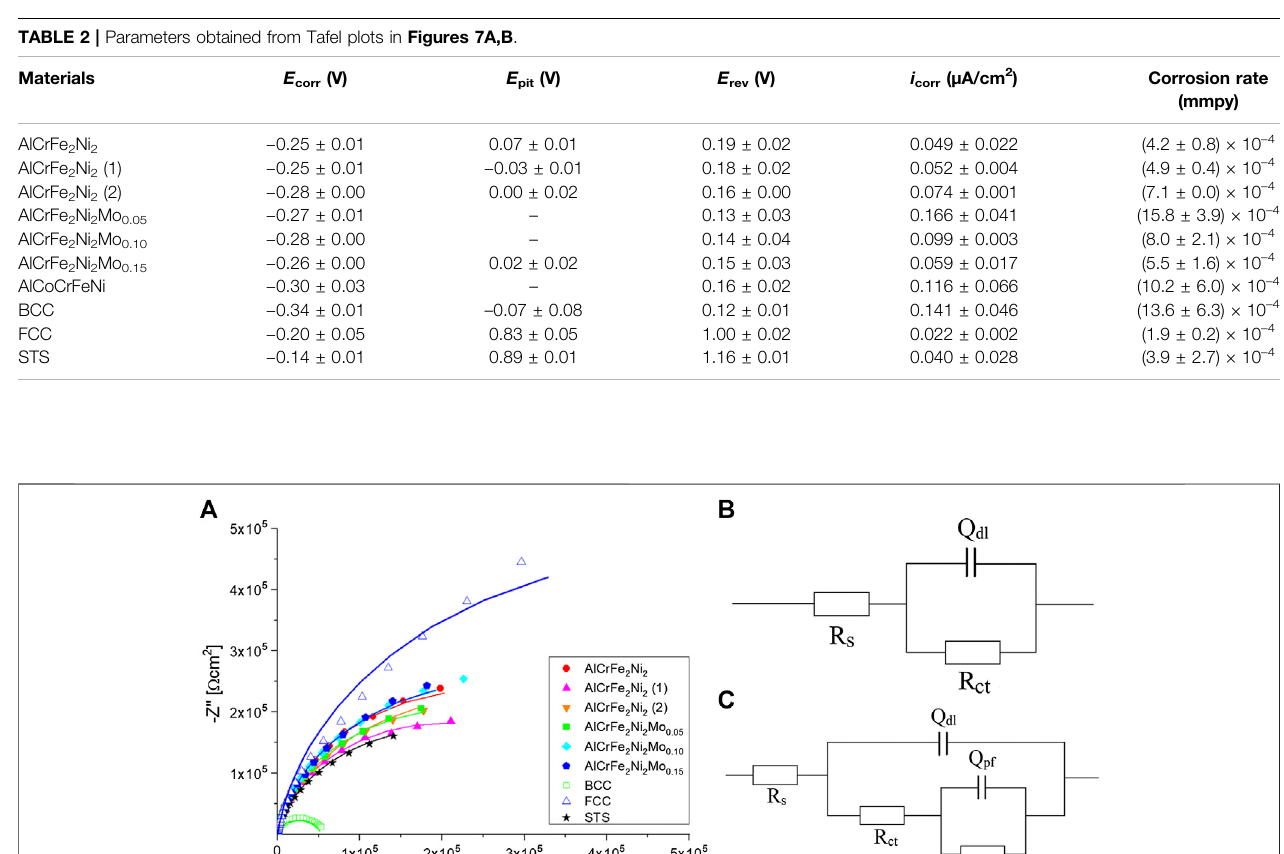
Frontiers in Materials |